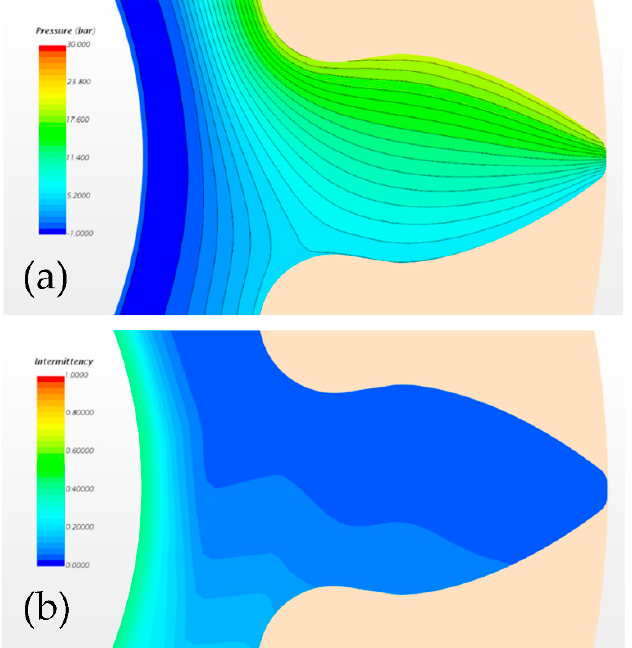
Figure 17. Pressure-intermittency correlation: ( a ) Isobaric curves on a zoomed view of the axial leakage; ( b ) intermittency on a zoomed view of the axial leakage. The background and overset regions are highlighted in beige.